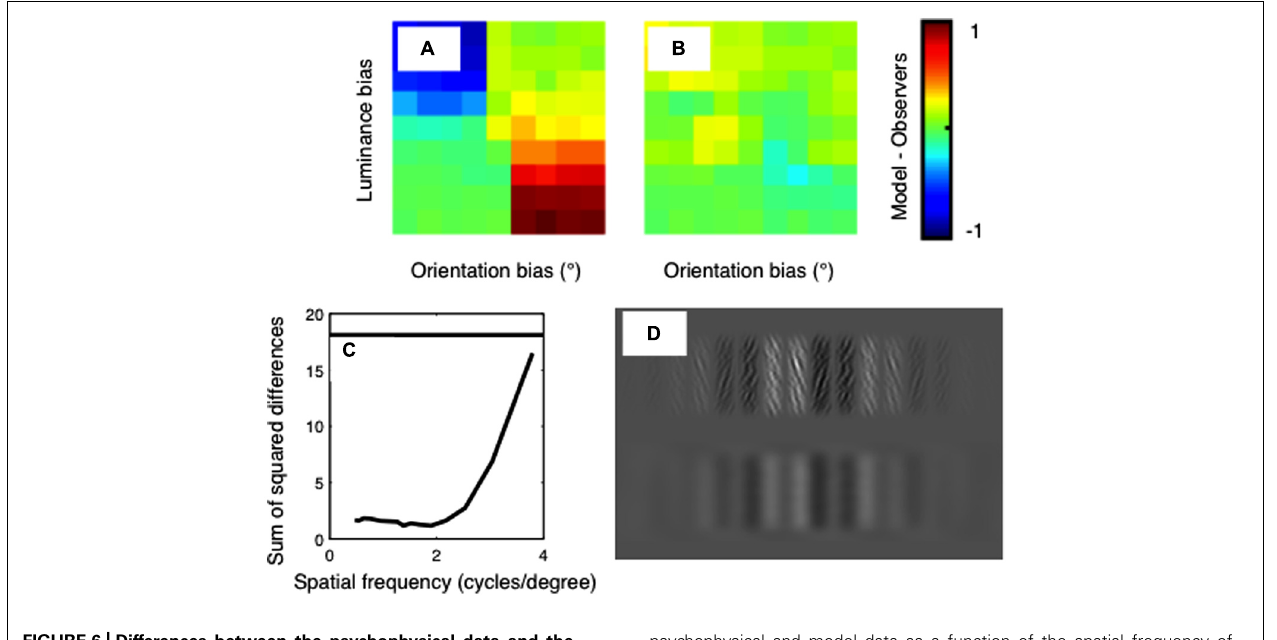
FIGURE 6 | Differences between the psychophysical data and the model results for (A) the standard correlation model and (B) the best-fitting correlation model. Color indicates the difference in proportion of “far” responses between the models and the averaged human psychophysical data. These differences are summarized in (C) , which shows the sum-of-squared differences between the